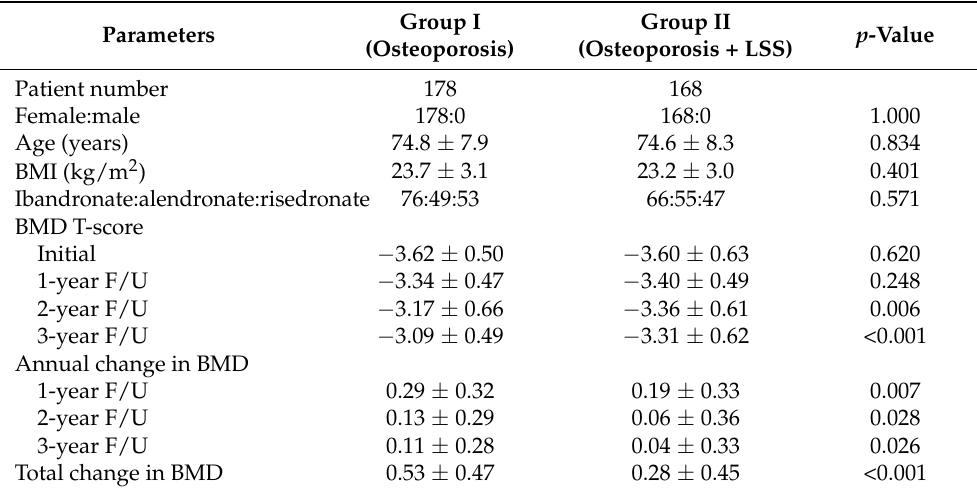
Table 1. Patient characteristics and BMD T-scores between the two groups.